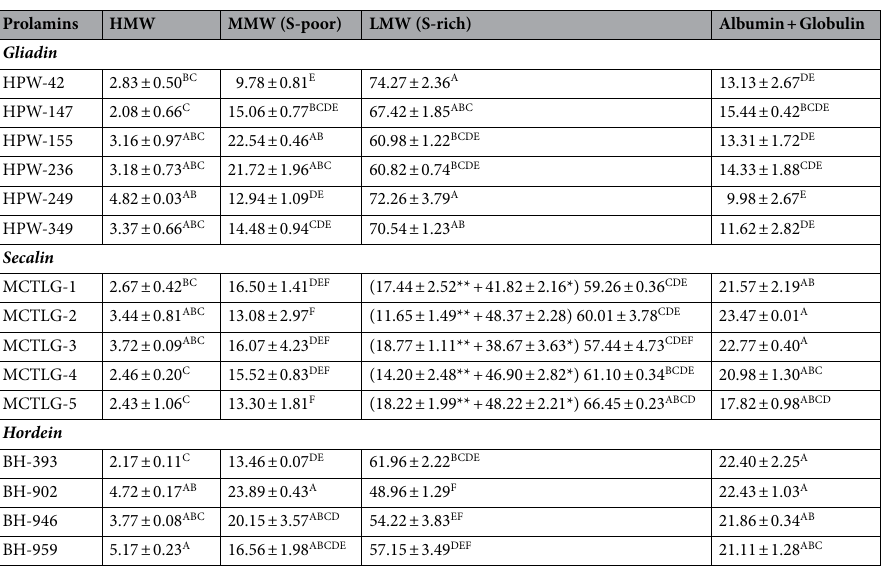
Table 1. The relative proportion of gliadin, secalin and hordein protein in SDS-PAGE and their classification according to molecular weight under reducing conditions. ** refers to γ-75 k-secalin fraction and * refers to γ-40 k-secalin. Mean ± SD with different superscripts in column differ significantly ( p ≤ 0.05); n = 3 for each